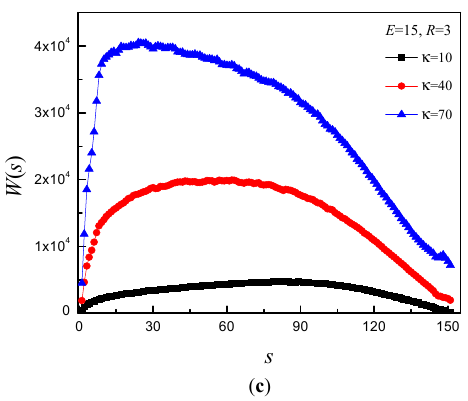
Figure 10. The waiting time distribution W ( s ) as a function of monomer s for N = 150 and different κ under: ( a ) E = 1.5; ( b ) E = 5; and ( c ) E = 15. Here, R = 3.